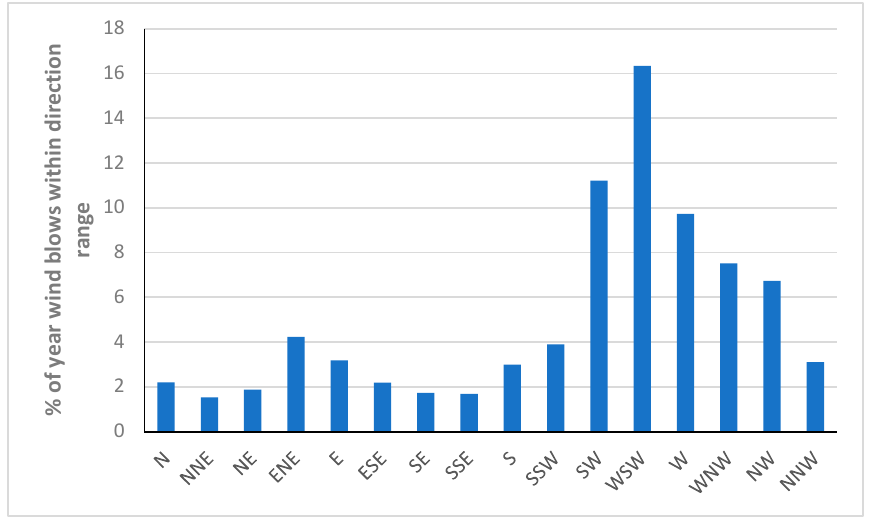
Figure 13. The percentage of year when the wind blows within direction ranges . Figure 14 shows the annual wind run from different directions. The maximum wind run can be seen in WSW (46,477 km/year), SW (29,546 km/year) and W (24,216 km/year) directions, respectively.